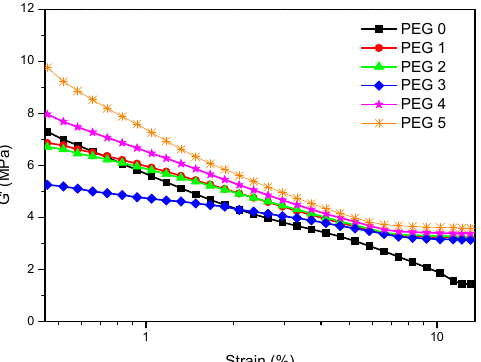
Figure 6. Dependencies of storage moduli G’ on the strain amplitude (Payne effect).